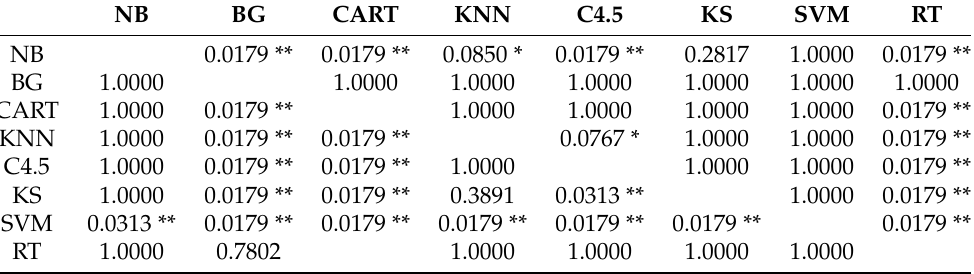
Table 21. Pairwise WSR test for accuracy of adults.